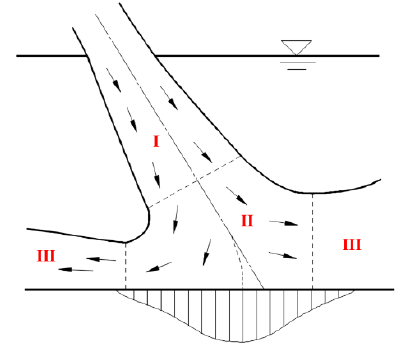
Figure 5. Schematic diagram of the flow regime.